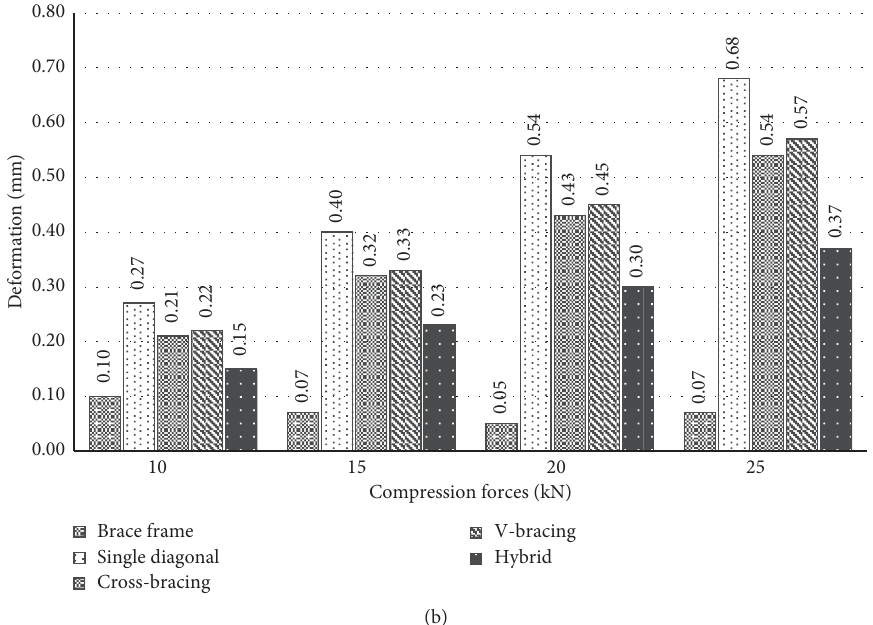
Figure 7: Deformation analysis at the (a) tie member (tension force) and (b) main member (compression force)